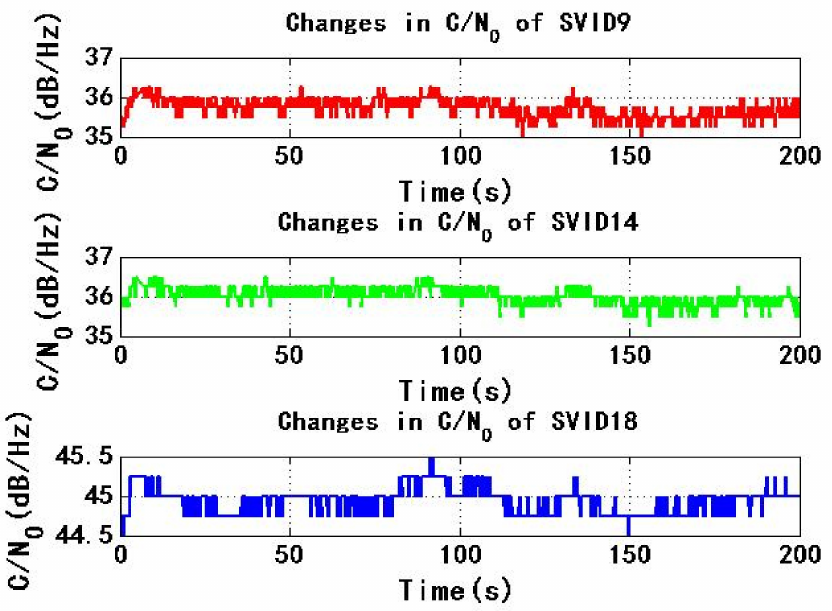
Figure 9. Changes in C / N 0 of SVID9, 14, 18 in experiment